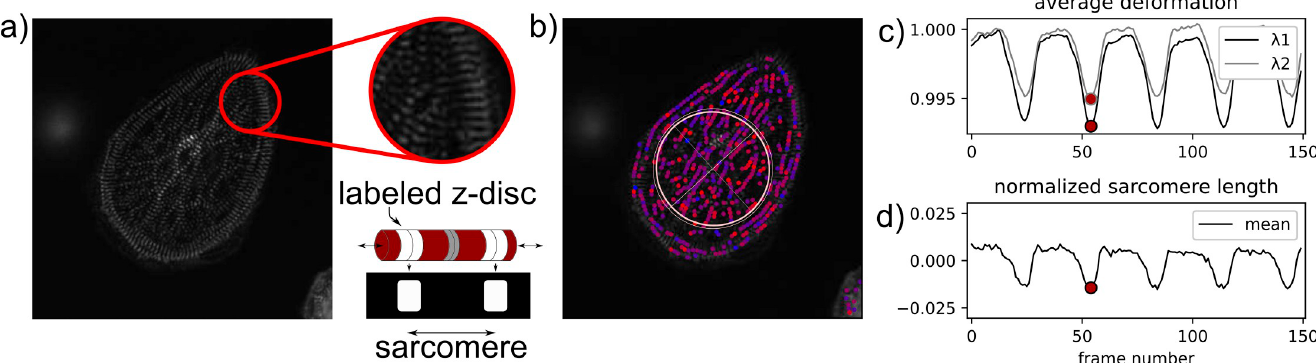
Fig 1. Analyzing movies of contracting human induced pluripotent stem cell-derived cardiomyocytes (hiPSC-CMs): (a) Still image of a beating hiPSC-CM movie. As per the schematic, z-discs, which define the ends of an � 2 μ m sarcomere, are fluorescently labeled; (b) Movie still with a schematic illustration of deformation gradient F avg and tracked sarcomeres overlaid, sarcomere color corresponds to contraction level with red indicating the highest level of contraction; (c) Magnitudes of average principal stretches ( λ 1 , λ 2 ) computed from F avg with respect to the movie frame number; (d) Average normalized sarcomere length with respect to the movie frame number. We note that the definitions of F avg , λ 1 , and λ 2 are introduced in this text.